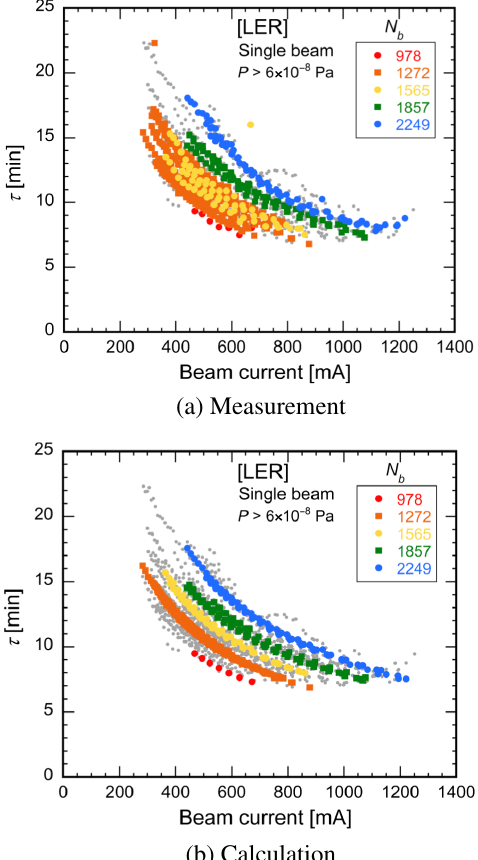
FIG. 13. Dependence of τ on I (a) measured and (b) calculated using the regression curve for several N b of 978 – 2249 for LER, where the P values higher than 6 × 10 − 8 Pa, from the 15th of May to the 21st of June 2022, were used for the MRA. Gray points correspond to all measured data.